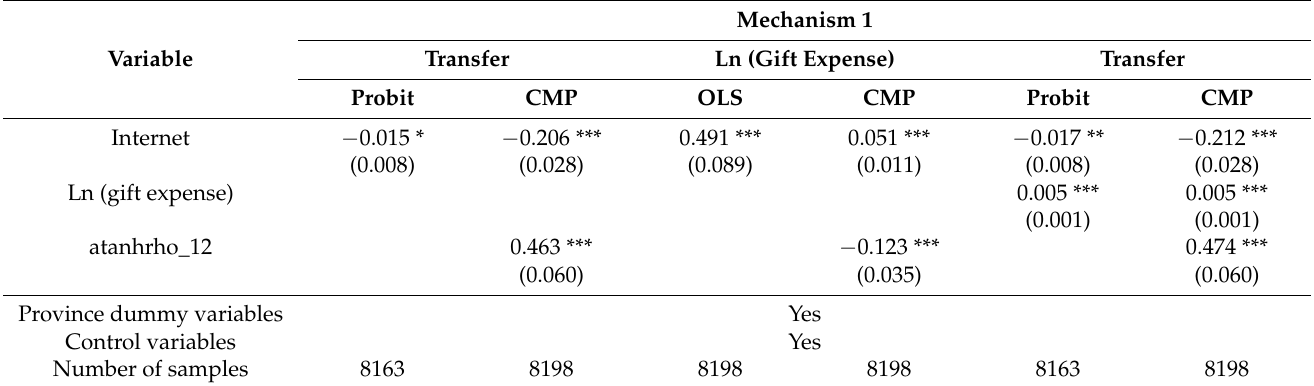
Table 7. Mechanism analysis results of social networks.